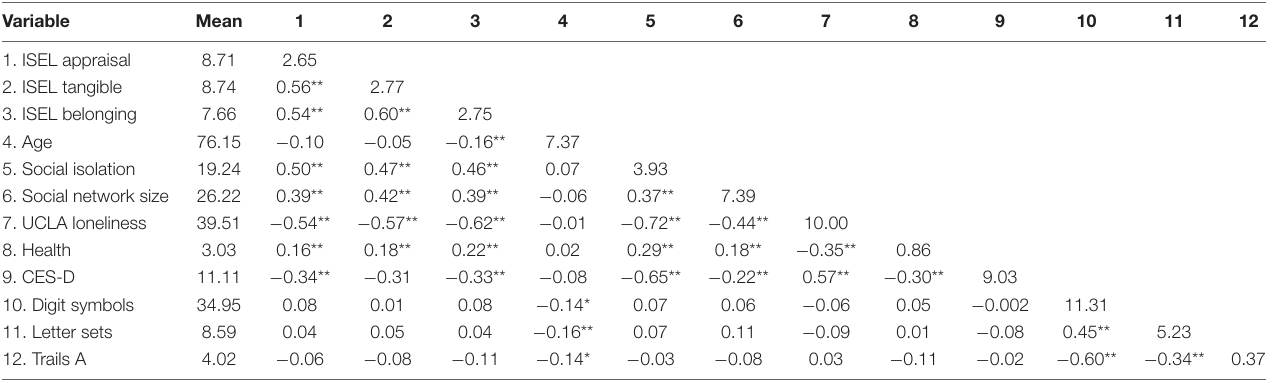
TABLE 1 | Intercorrelations and descriptive statistics of study variables.